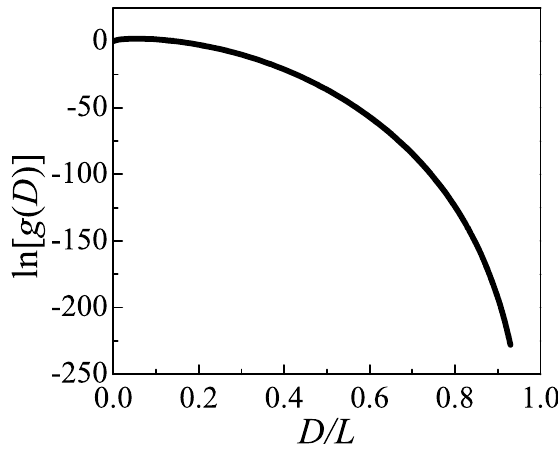
Figure 6. Density of states g ( D ) versus the distance between two injection points of an ideal loop. g ( D ) is plotted in a logarithmic plot, produced from the Wang–Landau Monte Carlo determination. D is scaled by loop length L . The absolute values of g ( D ) are meaningless, and g ( D = 0 ) is chosen to be